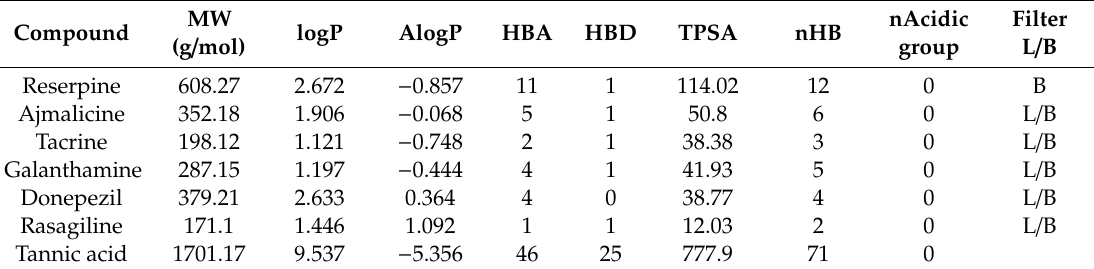
Pharmacokinetics ADMET prediction by Drulito against Lipinski rule of five and blood-brain-barrier